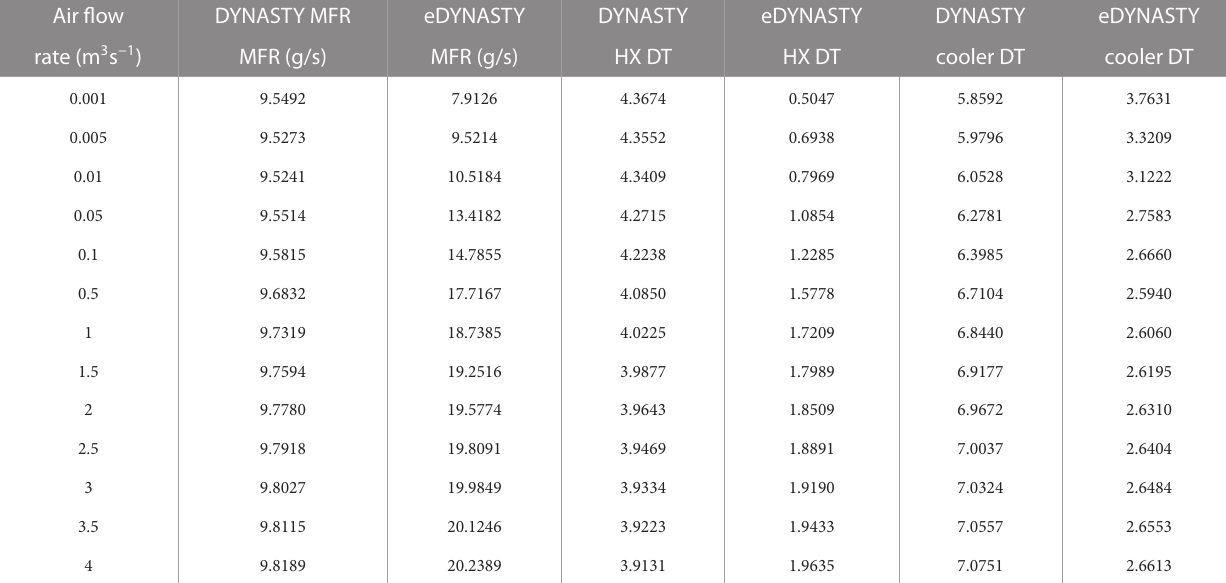
TABLE2 eDYNASTYcoolerparametricanalysisresults,massflowrate(MFR),andtemperaturedifferences(DT). Air